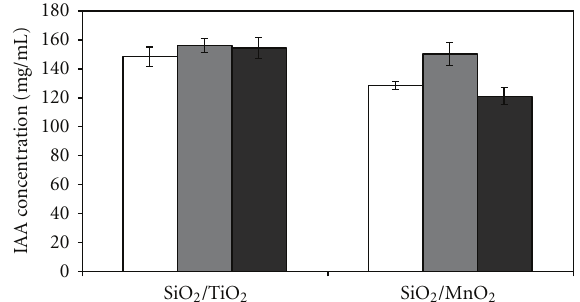
Figure 3: Operational stability of the free and immobilized cells of Klebsiella oxytoca on 6% SiO 2 /TiO 2 (first cycle (white bar), second cycle (dark grey bar), third cycle (black bar), and fourth cycle (light grey bar)). Conditions: nitrogen-free malate (NFb), 100.0 μ gmL − 1 of L -tryptophan, pH 6.8, 28 ◦ C and 120